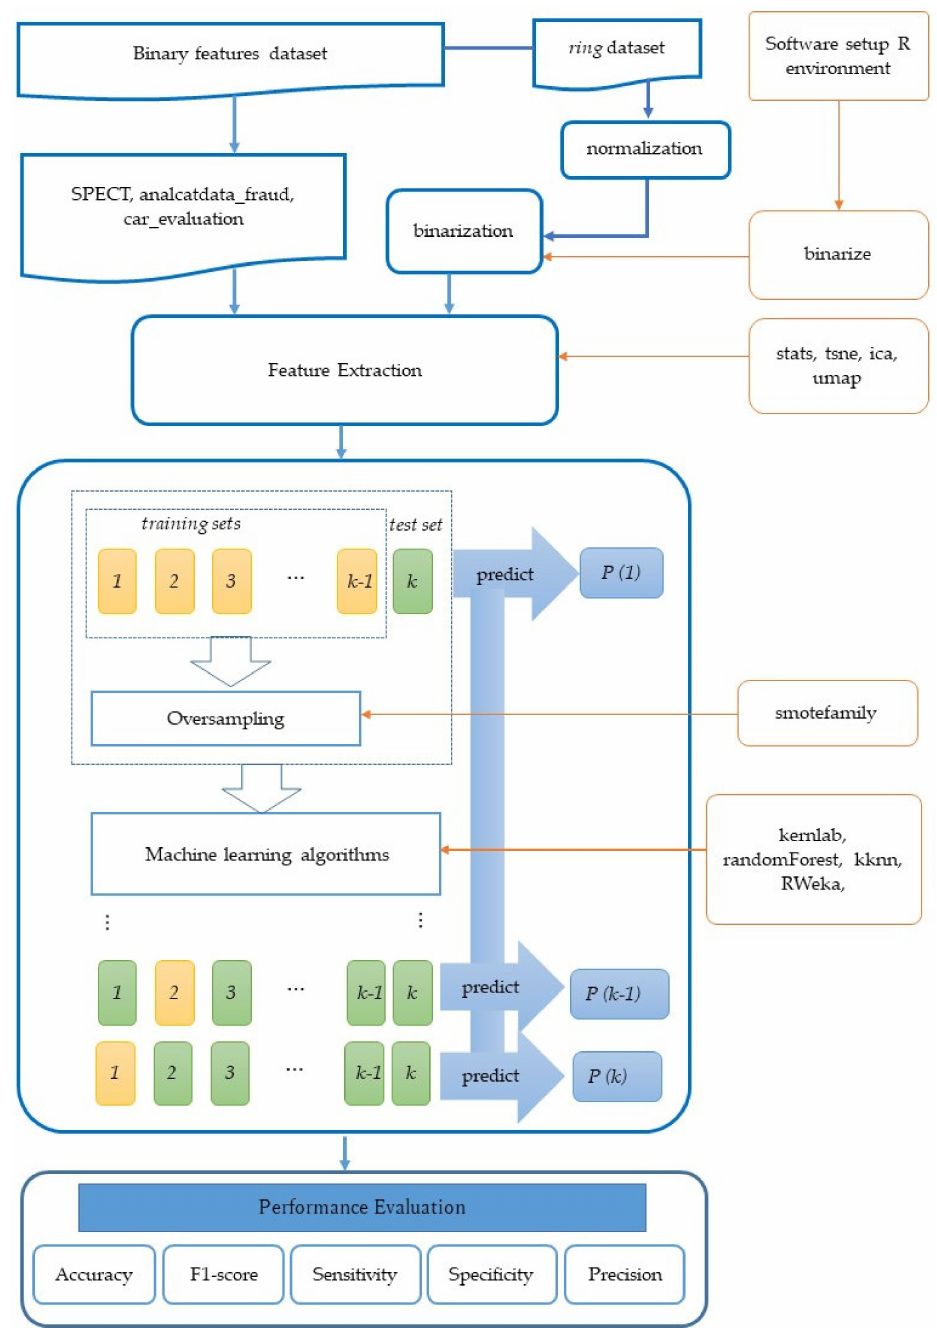
Figure 1. The flowchart of the proposed